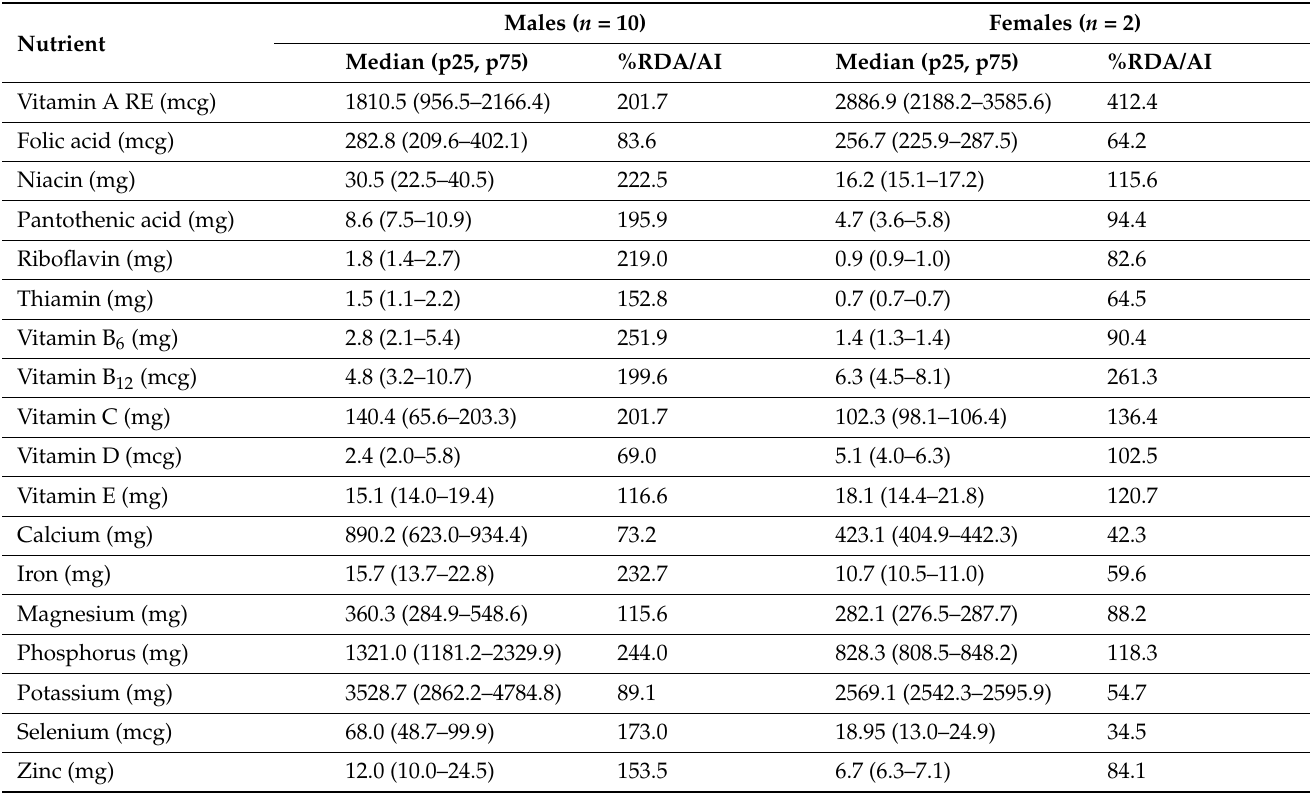
Table 4. Micronutrient intake ( n = 12).